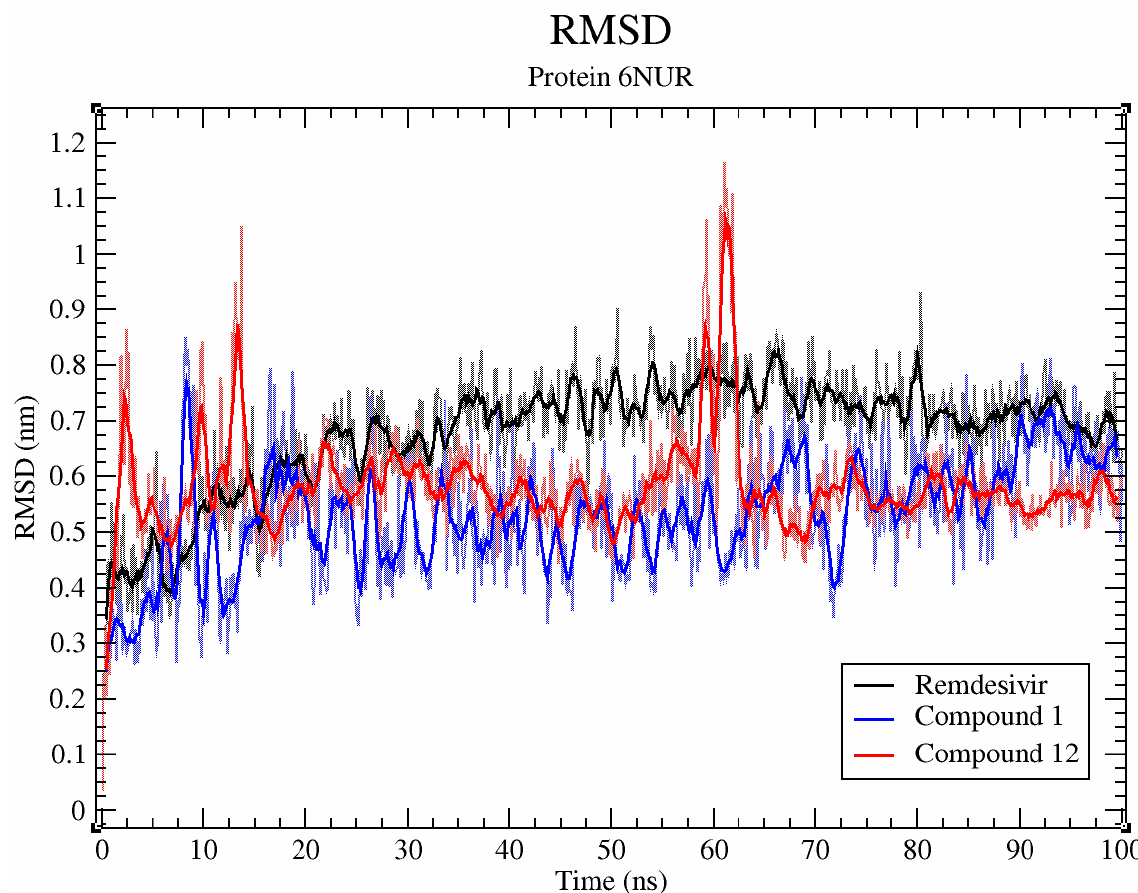
Figure 4. RMSD plot of compounds 1 , 12 , and remdesivir during a 100 ns MD simulation with SARS-CoV-2 RdRp. Compounds 1 , 12 , and remdesivir interact with the SARS-CoV-2 RdRp (PDB ID